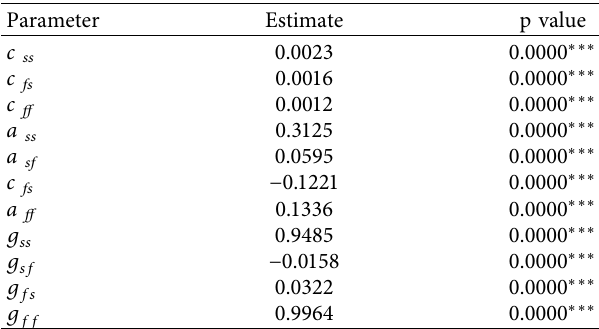
Table 9: Estimates of the BEKK-GARCH(1,1).